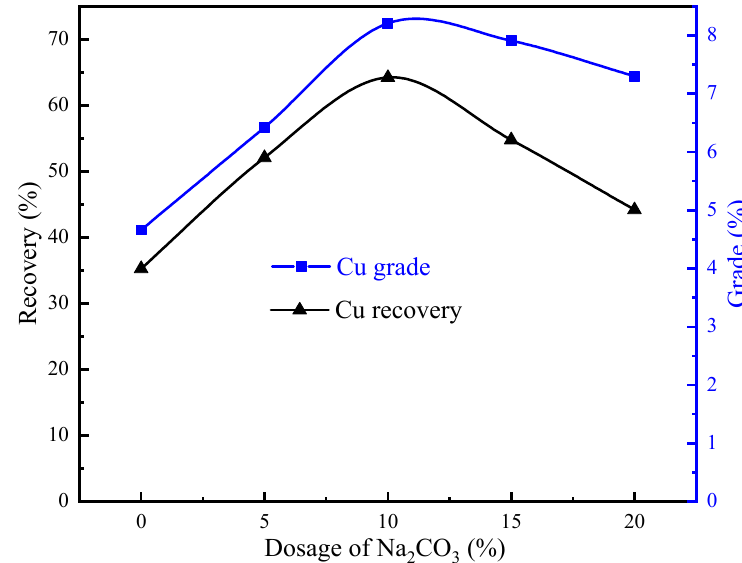
Figure 12. Effects of Na 2 CO 3 on the Cu recovery of modified Cu slag. Figure 12. E ff ects of Na 2 CO 3 on the Cu recovery of modified Cu